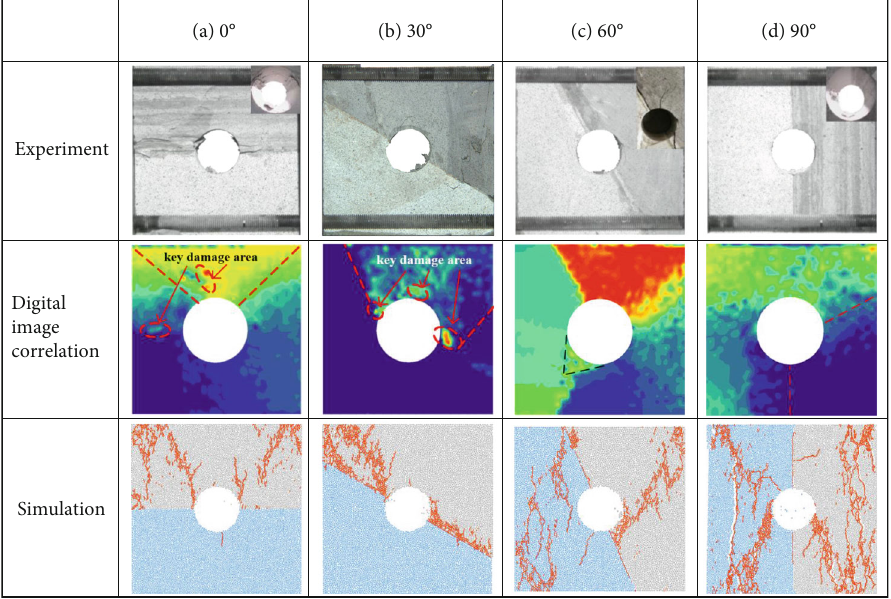
Figure 4: Comparison between simulation results and laboratory test